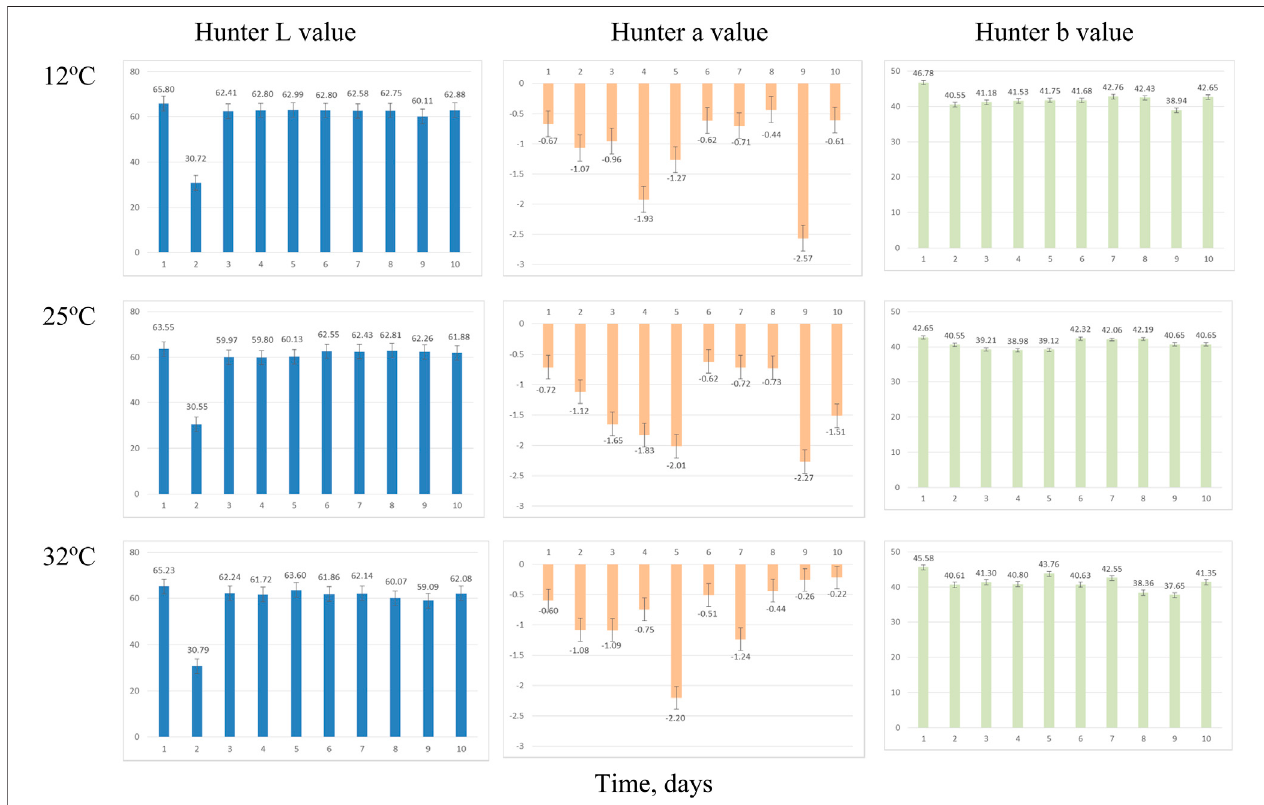
FIGURE 8 | Average Hunter color values change over time for thin stillage sampling due to incubation temperatures. Error bars denote 1 standard deviation.